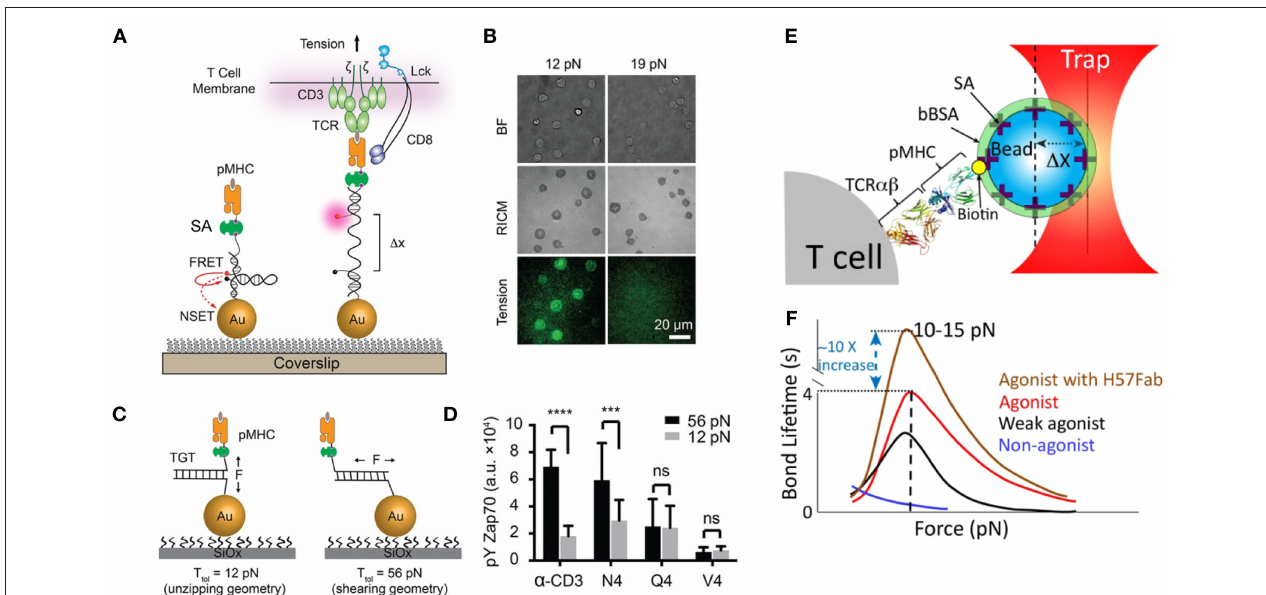
FIGURE 1 | Piconewton (pN) molecular forces are important to TCR antigen specificity. (A) Molecular tension probes are comprised of a fluorophore-quencher pair flanking a force-extensible domain. Molecular forces extend the probe, separating the fluorophore-quencher pair. DNA-based molecular tension probes, highlighted here, produce up to a 100x increase in fluorescence under the influence of cellular forces. (B) Using DNA molecular tension probes, OT-1 CD8 + T-cells were found to exert defined (12–19pN) forces through the TCR. (C) Tension gauge tethers rupture irreversibly when receptor forces reach a threshold, capping the maximum tension a cell can exert through a receptor. (D) OT-1 CD8 + T-cells exhibit more potent activation when the pMHC-TCR complex is more mechanically stable. (E) Optical tweezers, formed by trapping a bead near the focus of a tightly focused laser, enable precise control over the movement of the bead and are useful for exerting pN forces on receptor-ligand interactions. (F) Optical tweezer manipulation of pMHC-presenting beads enabled the application of pN forces to TCR-pMHC complexes. TCR-pMHC bond lifetime increases for agonist pMHC (catch bond behavior) but decreases for non-agonist pMHC (slip bond behavior). The TCR FG loop is thought to elongate under cellular force and to be responsible for catch bond behavior. Stabilizing the FG loop with the H57Fab frag further enhances bond lifetime. (A–D) Are adapted from with permission from Liu et al. [ 20] while panels (E,F) are adapted from Feng et al. [21] licensed under Creative Commons (CC BY 4.0). NSET, near surface energy transfer; BF, brightfield; RICM, reflection interference contrast microscopy which displays cell-surface contact area; TGT, tension gauge tether; T tol , the tension tolerance of a TGT, the force at which the TGT ruptures within 2s; bBSA, biotinylated bovine serum albumin; SA, streptavidin. *** Indicates p < 0.001 and **** indicates p <